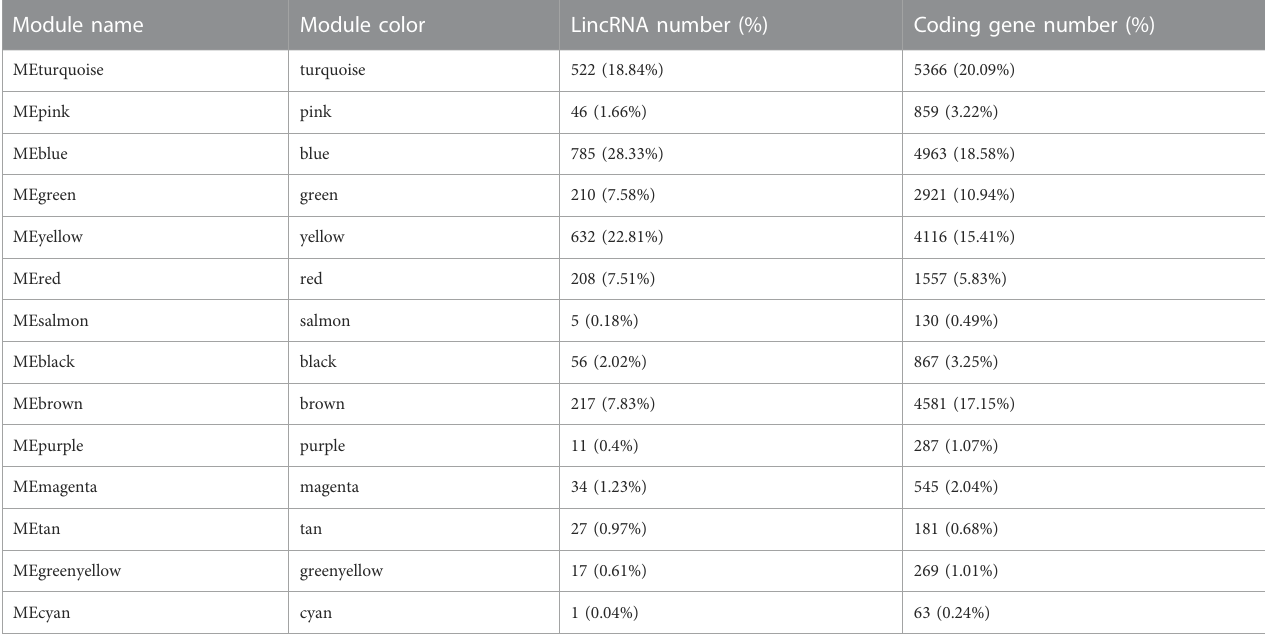
TABLE 1 The statics of modules in WGCNA